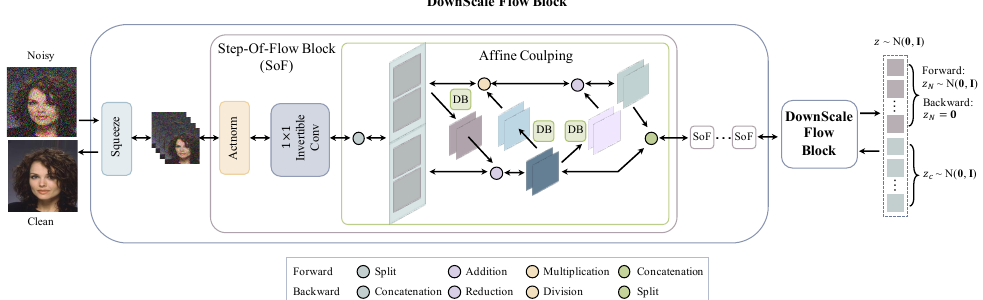
Figure 3. Our FDN Network Architecture. FDN consists of several invertible DownScale Flow Blocks. Module DB is the Dense Block proposed in [30]. The forward pass encodes the corrupted image to latent variables z , which follow a Gaussian distribution, i.e., z = ( z N , z C ) ∼ N ( 0 , I ) . The latent representations of noise z N are set to 0 , combined with the clean latent variables z C as a new latent representation ˆz . The backward pass decodes ˆz to the denoised image.